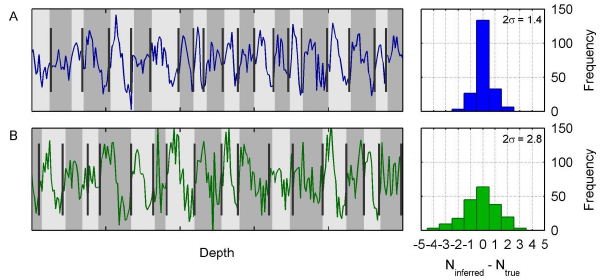
Fig. 4. Test of layer detection algorithm on ensembles of two types Fig. 4: Test of layer detection algorithm on ensembles of two types of synthetic data. Left: 2 of synthetic data. Left panel: example data series. Grey banding in- Example data series. Grey banding indicates the original layer boundaries, based on which the 3 dicates the original layer boundaries, based on which the data has data has been produced. Dark grey bars signify the location of inferred layer boundaries. 4 been produced. Dark grey bars signify the location of inferred layer Right: Differences between inferred (N inferred ) and true (N true ) number of layers in the data 5 boundaries. Right panel: differences between inferred ( N inferred ) based on an ensemble of 200 data series with approximately 50 layers each. (A): Data is 6 and true ( N true ) number of layers in the data based on an ensemble produced as a sequence of sinusodials generated by the parameters φ = 1, Φ = 0.5 2 , and σ ε = 7 of 200 data series with approximately 50 layers each. (A) Data is 0.5 (Eq. 2). (B): As A, but with higher amounts of noise and variability in the layer signal ( φ 8 produced as a sequence of sinusodials generated by the parameters = 1, Φ = 1, σ ε = 1). 9 ϕ =1, 8 =0.5 2 , and σ ε =0.5 (Eq. 2). (B) As (A) , but with higher 10 amounts of noise and variability in the layer signal ( ϕ =1, 8 =1, σ ε